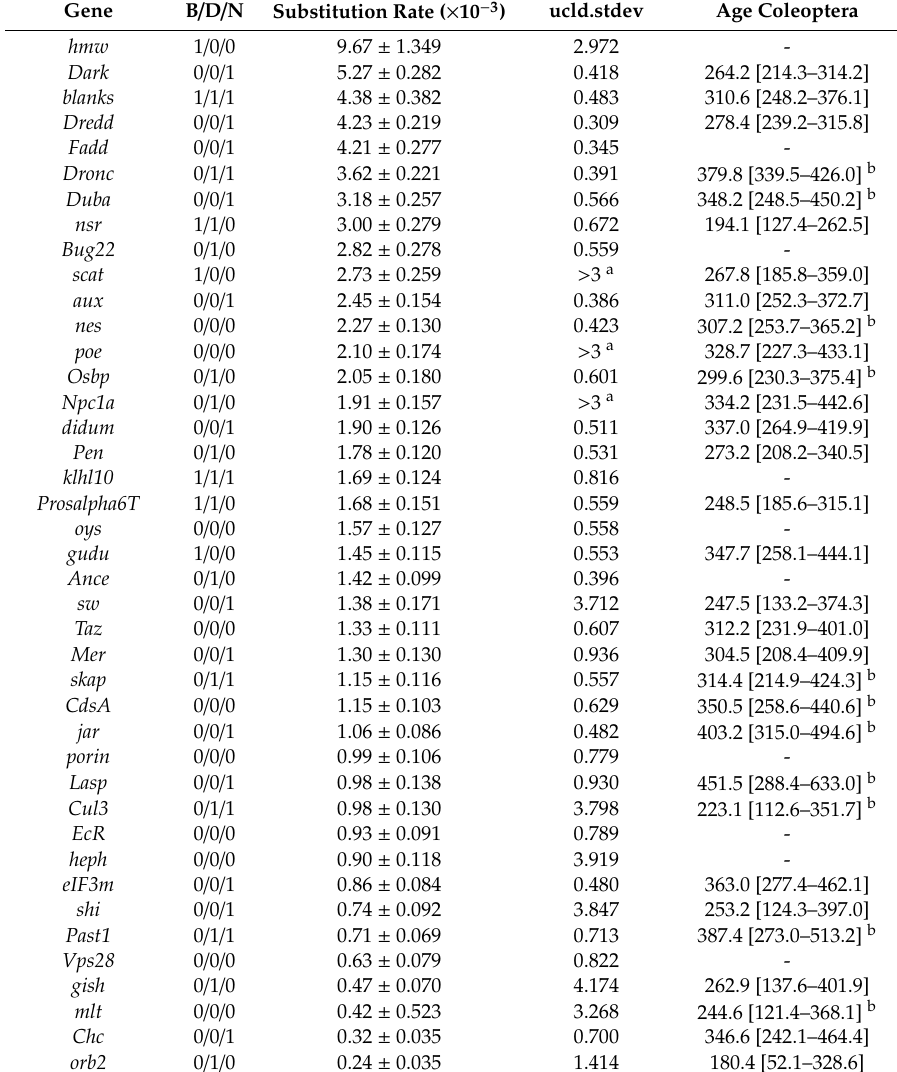
Table 4. Characteristics of amino acid datasets of sperm individualization proteins of insects deduced from information in public databases (B: unbiased [0] and sex-biased [1] genes; N: non-interacting [0] and interacting [1]), as well as information deduced from their phylogenetic analyses, including duplications (D: single [0] and multicopy [1]), evolutionary rates, evolutionary rate heterogeneity (ucld.stdev), and the estimated age of the clade